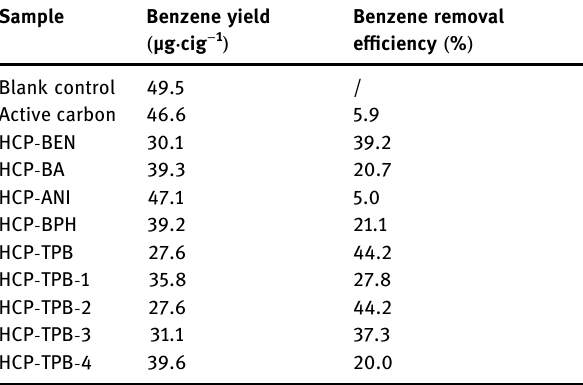
Table 2: Benzene removal e ffi ciency of HCPs in cigarette smoke